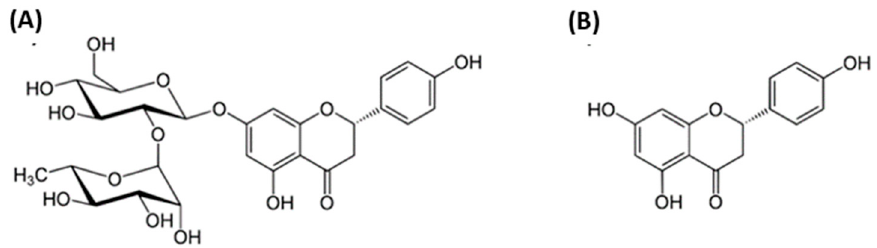
Figure 1. Chemical structures of naringin (NRG) ( A ) and naringenin (NRGN) ( B ).